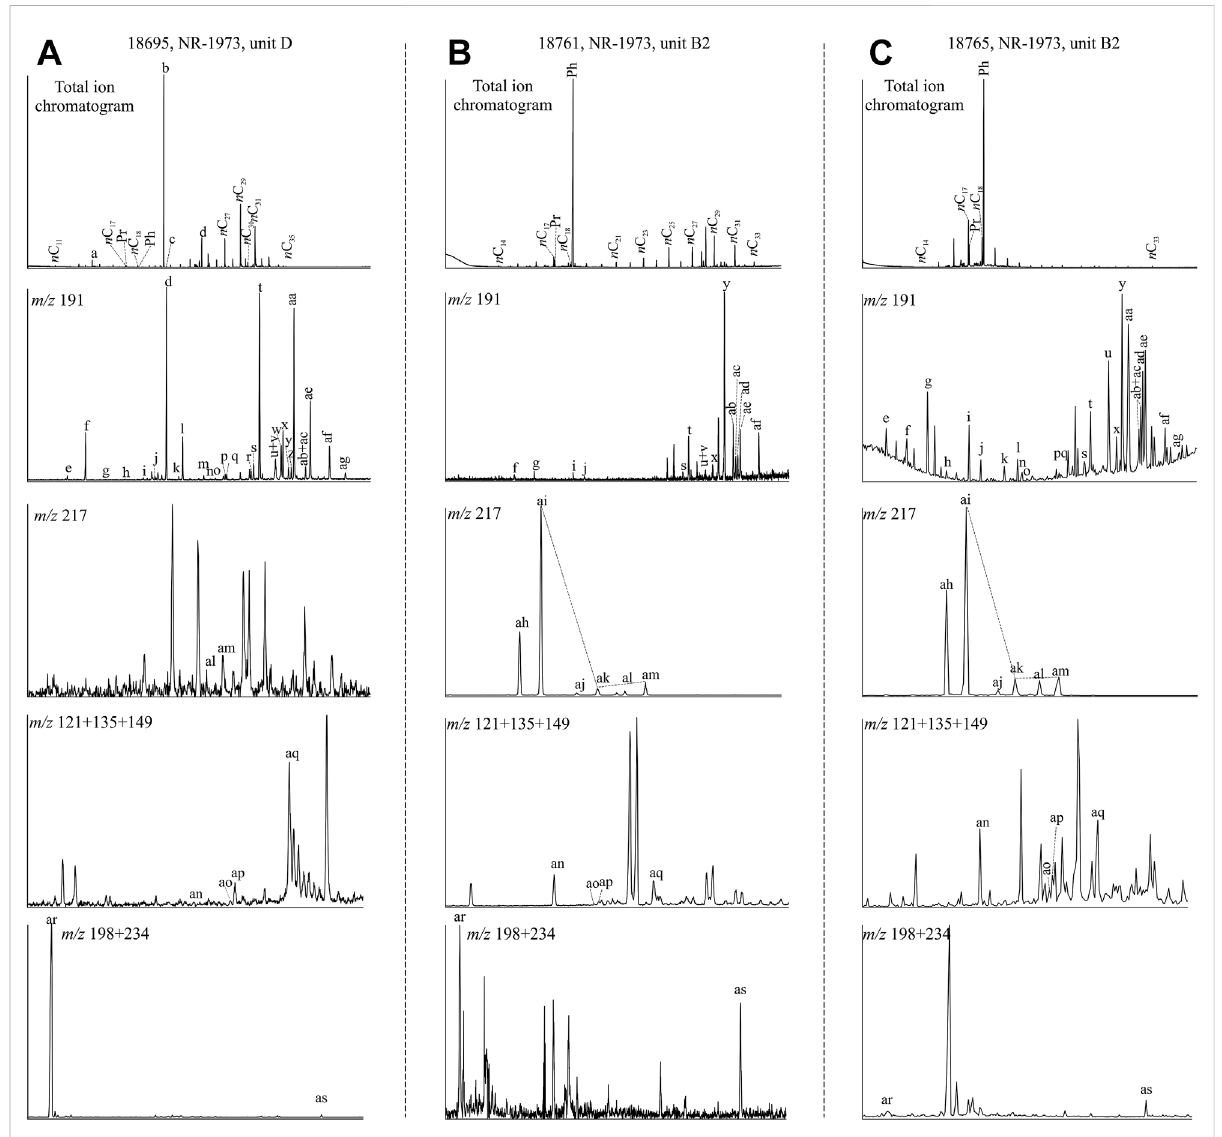
FIGURE 4 Totalionchromatogramsandmasschromatogramsofextractablelipidsfromthepost-impactsedimentsintheNördlingerRies(assignmentsto the identi fi ed peaks see Table 1). Chromatograms for (A) coaly shale in uppermost unit D with a maximum of n -alkanes in the long chain range, (B) one of few samples with a weak bimodal n -alkane distribution (unit B2), and (C) a typical sample from unit B in the Nördlinger Ries (also unit B2) showing a maximum in the short chain n -alkane range. m/z 191 traces show hopanoids distribution; m/z 217 shows steranes distribution; m/z 121+135+149 traces shows the MTTCs distribution and m/z 198+234 traces present retene and cadalene. See Figure 2 for stratigraphic